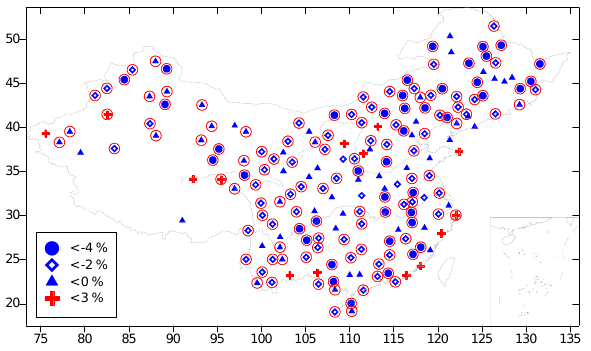
Fig. 7. The same as Fig. 1, but for daily temperature range (DTR) analysis at 192 stations. The significant decline in DTR is obvious Figure 7. The same as Figure 1, but for daily temperature range (DTR) analysis at 192 over much of China, generally due to larger increases in the mini- stations. The significant decline in DTR is obvious over much of China generally due to mum temperatures compared to maximum temperatures. As a mat- larger increases in the minimum temperatures compared to maximum temperatures. As ter of fact, a decreasing trend in maximum temperature (not shown) a matter of fact, a decrease trend in maximum temperature (not shown) is observed in is observed in the eastern part of China, where visibility decreased eastern part of China where visibility decreased greatly.